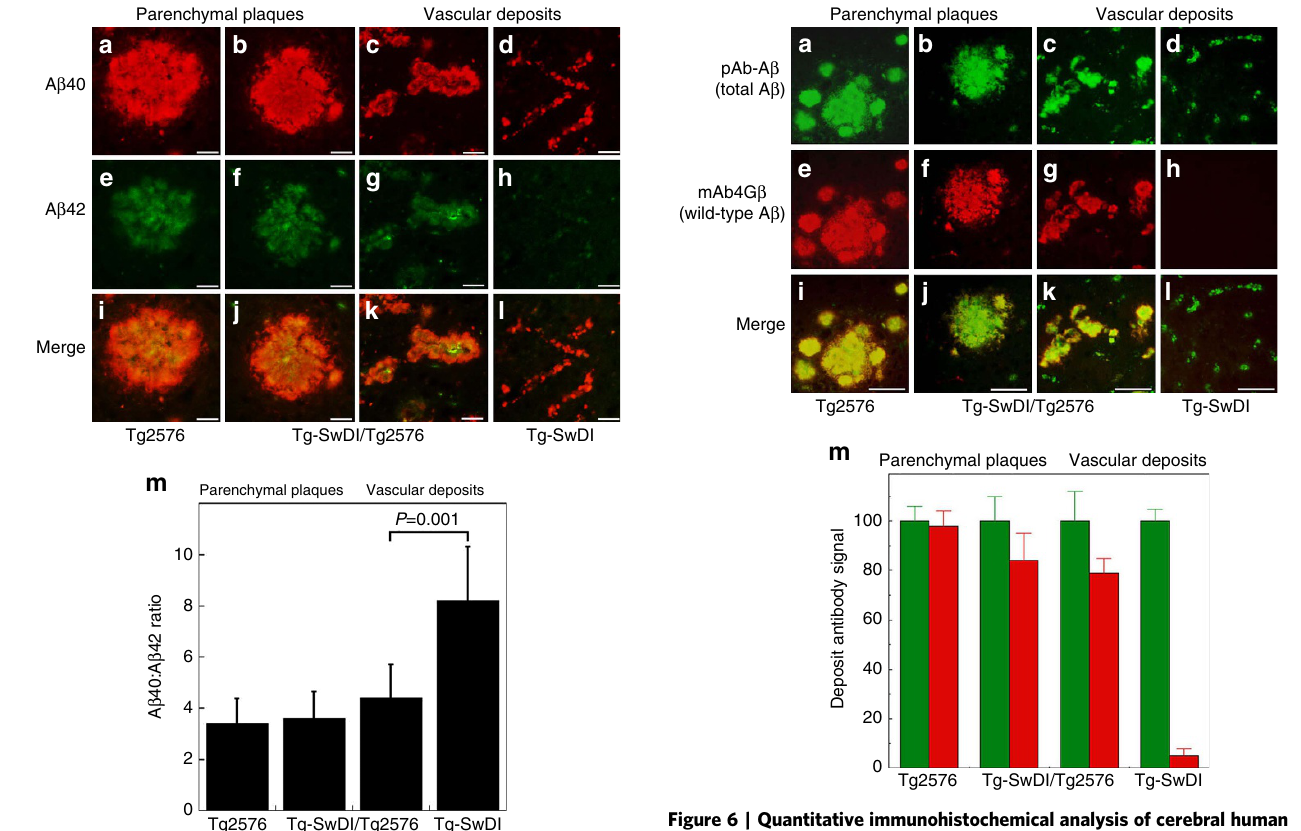
Figure 5 | Quantitative immunohistochemical analysis of cerebral A b 40 and A b 42 deposition in the different transgenic mice. Brain sections obtained from the different transgenic mouse lines at 18 months of age were double immunolabelled for A b 40 (red) ( a – d ) and A b 42 (green) ( e – h ) and images were merged ( i – l ). Scale bars, 20 m m. ( m ) The levels of A b 40 and A b 42 in parenchymal plaque and capillary deposits were determined in the different transgenic lines and expressed as the ratio of A b 40:A b 42. The data presented are the mean ± s.d. of 15 deposits per each line of mice. Pair-wise comparisons were made using t -test and significant differences ( P o 0.05) are indicated and limited to three decimal places.